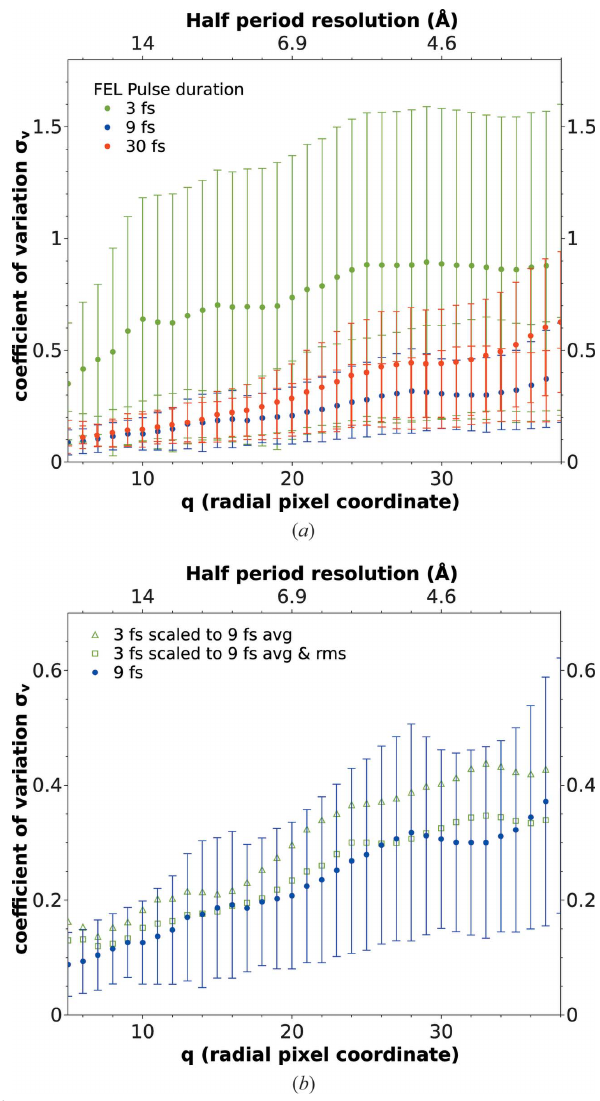
Figure 3 ( a ) The coefficient of variation of oriented three-dimensional diffraction volumes for pulse durations of 3, 9 and 30 fs. ( b ) The coefficient of variation for a pulse duration of 9 fs and re-scaled coefficients for 3 fs. Triangles: every pattern has been multiplied by a constant factor of 3.3 to match the average photon count in the 9 fs patterns. Squares: every 3 fs pattern has been multiplied by an individual factor such that the average and r.m.s. photon counts match the 9 fs